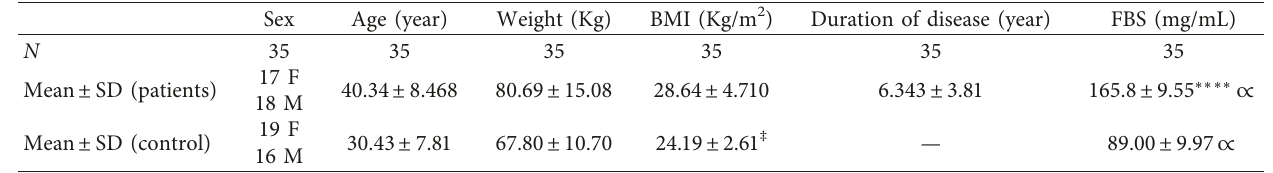
Figure 4: SEM images of urease enzyme (a), chitosan NPs particles (b), and immobilized urease-chitosan NPs (c). Scale bars � (a) 50 μ m, (b) 200 μ m, and (c) 500nm. Table 1: A description of the studied groups. Values were expressed by mean ± SD.